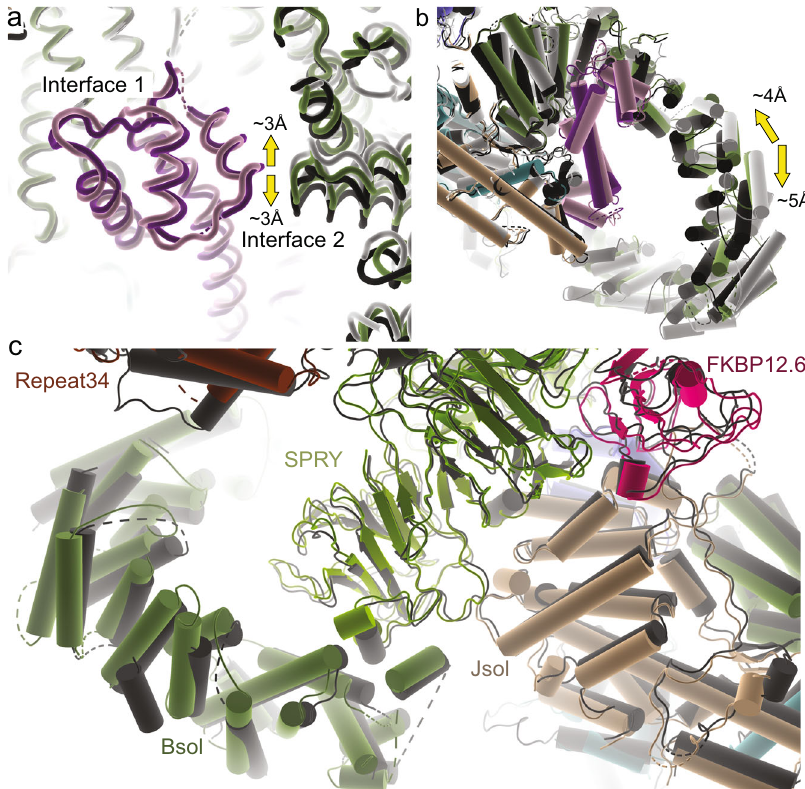
Fig. 6 ApoCaM binding to R615C pRyR1 results in two conformations different from the structure without apoCaM. a Superposition, based on interface 1 helices, of R615C pRyR1 without apoCaM bound (colors) and with apoCaM bound in the closed (white) and open (black) conformation. The corresponding apoCaM chains are shown in light (closed) and dark (open) purple. The interface 2 region for R615C pRyR1 without apoCaM is in an intermediate conformation and has to move in one of two opposing directions upon apoCaM binding. b Same superposition as in panel ( a ), showing how the bending of the Bsol downstream of interface 2 is also intermediate for R615C pRyR1 without apoCaM bound. c Overall superposition of R615C pRyR1 (colors) and open R615C pRyR1 + apoCaM (dark gray), showing that the conformational differences in the Bsol are transferred to the SPRY domains and Jsol of a neighboring subunit.